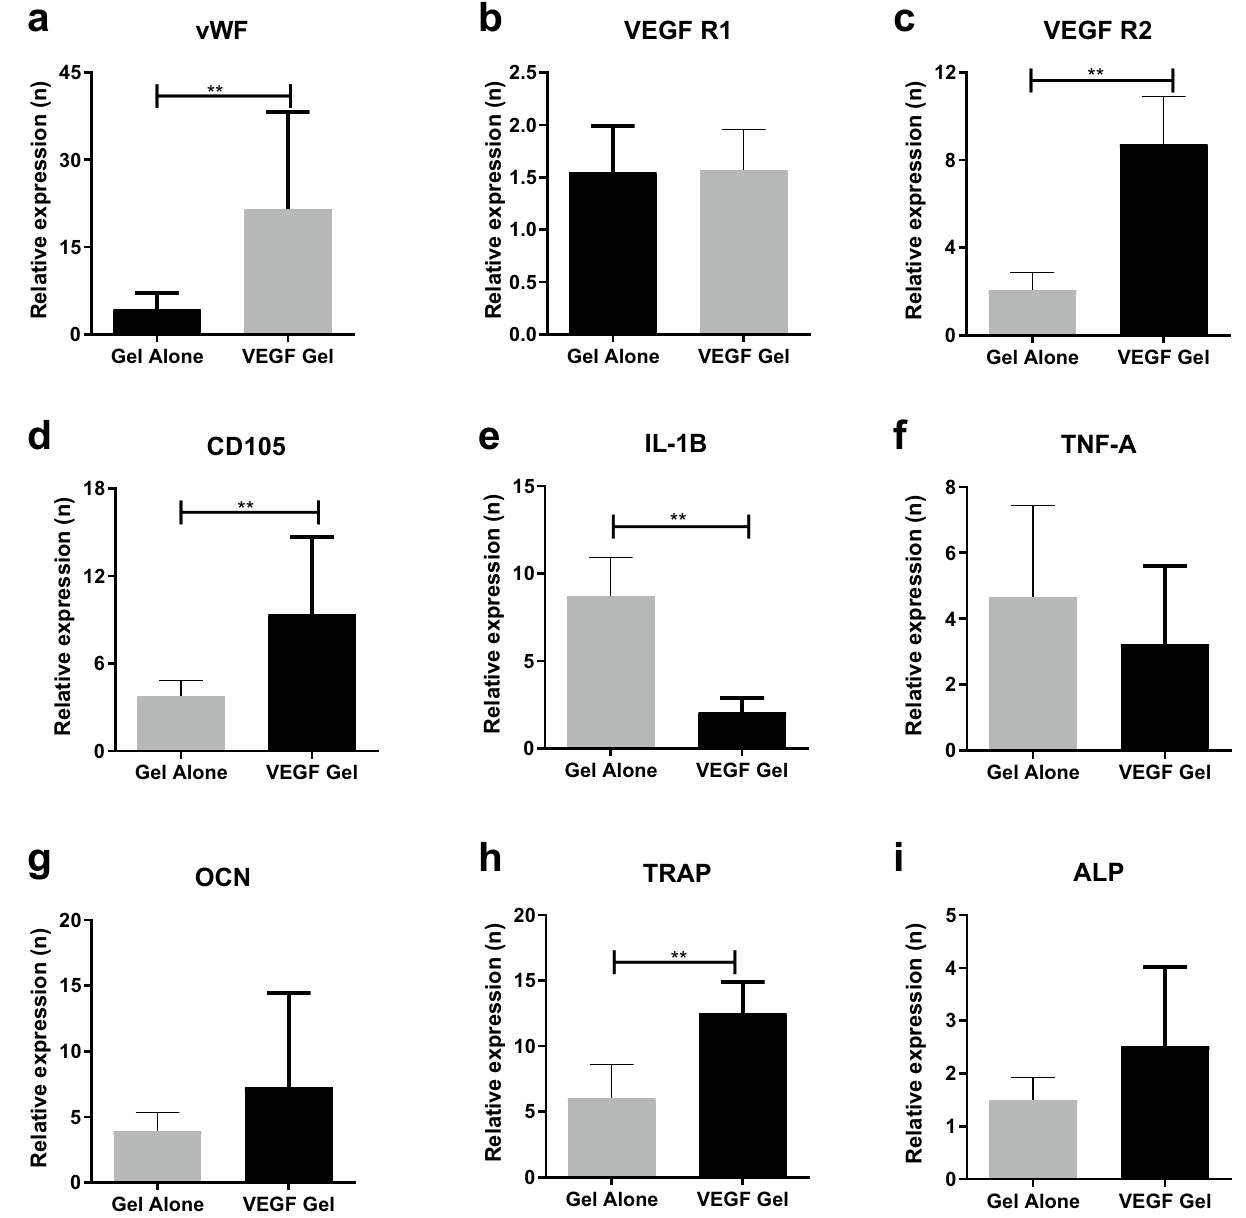
Figure 7. Relative gene expression within MRONJ lesion (defect) hard tissue normalized to no-gel levels; vWF ( a ), VEGF-R1 ( b ), VEGF-R2 ( c ), CD105 ( d ), IL-1β ( e ), TNF-α ( f ), OCN ( g ), TRAP ( h ) and ALP ( i ) **p <